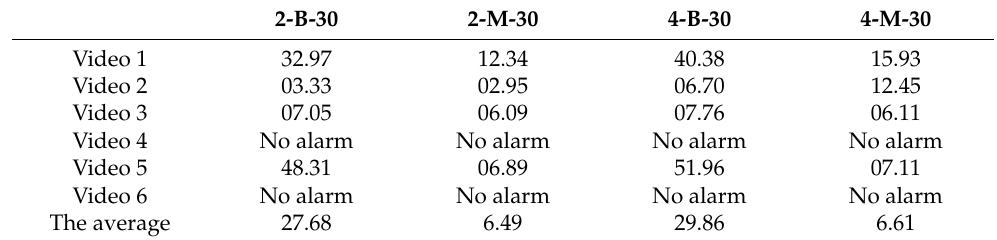
Table 7. The response time in seconds for four running, where B denotes boundary testing and M denotes middle testing. Further, [2–4] is the number of testing frames and [30] is the length of sequence. For example, 4-B-30 indicated that the FEAPAS tested four frames on the boundary of the sequence with 30 frames for each decision. If all four frames are classified as pain, then FEAPAS activates the alarm and stores the tested frames/images with date, time, and pain level.